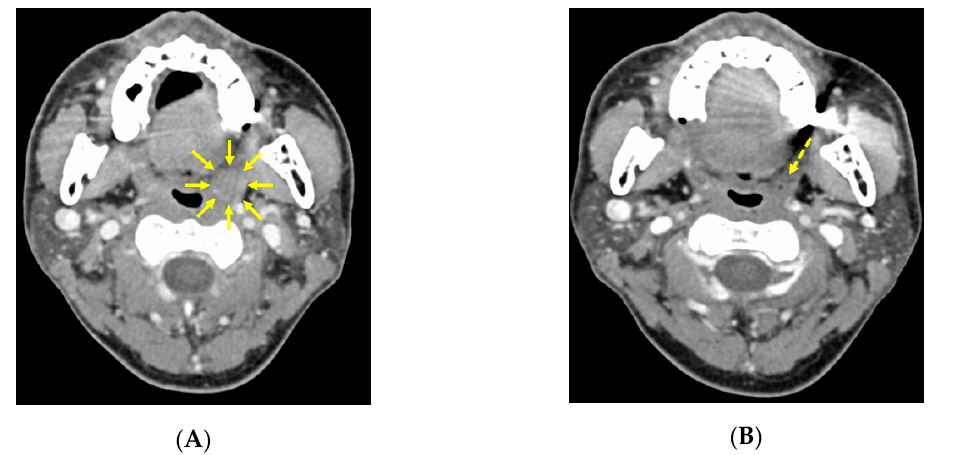
Figure 2. CT imaging findings of the primary tumor before and after neoadjuvant chemotherapy. ( A ) Pre-chemotherapy CT scan showing the left oropharyngeal lateral wall with the primary tumor is larger than the right side. The tumor is about 15 × 15 mm (arrows). ( B ) CT scan after the second neoadjuvant chemotherapy course showing a markedly smaller remnant left tonsil mass.